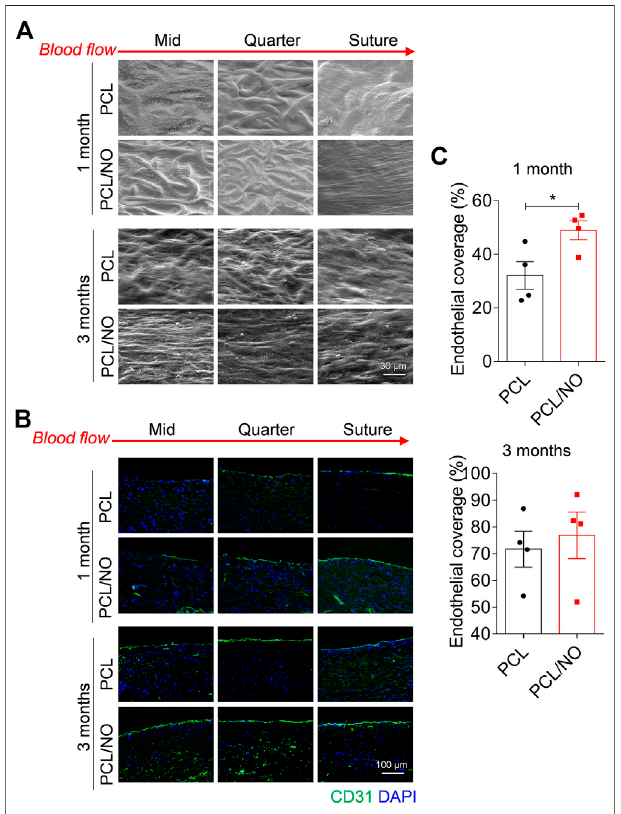
FIGURE 3 | Sustained NO release from nitrate-functionalized SDVGs increases endothelialization. (A) SEM images of the luminal surface of the SDVGsat themid-,quarter- and suture-site segmentsafter 1 month andafter 3 months (scale bars (cid:1) 30 µm). Images orientated to blood fl ow direction. Red dashed boxes indicate location of zoomed inset images outline in red. (B) CD31 staining of endothelial cells within transverse sections of the SDVGs at the mid-, quarter- and suture-site segments after 1 month (top rows) and after 3 months (bottom rows) . Images orientated to blood fl ow direction. Scale bars (cid:1) 100 µm. (C) Quanti fi cation of the average percentage of endothelial cell monolayer coverage of SDVG lumens at 1 month (top) and at 3 months (bottom) . Images and data are representative of n (cid:1) 4 independent